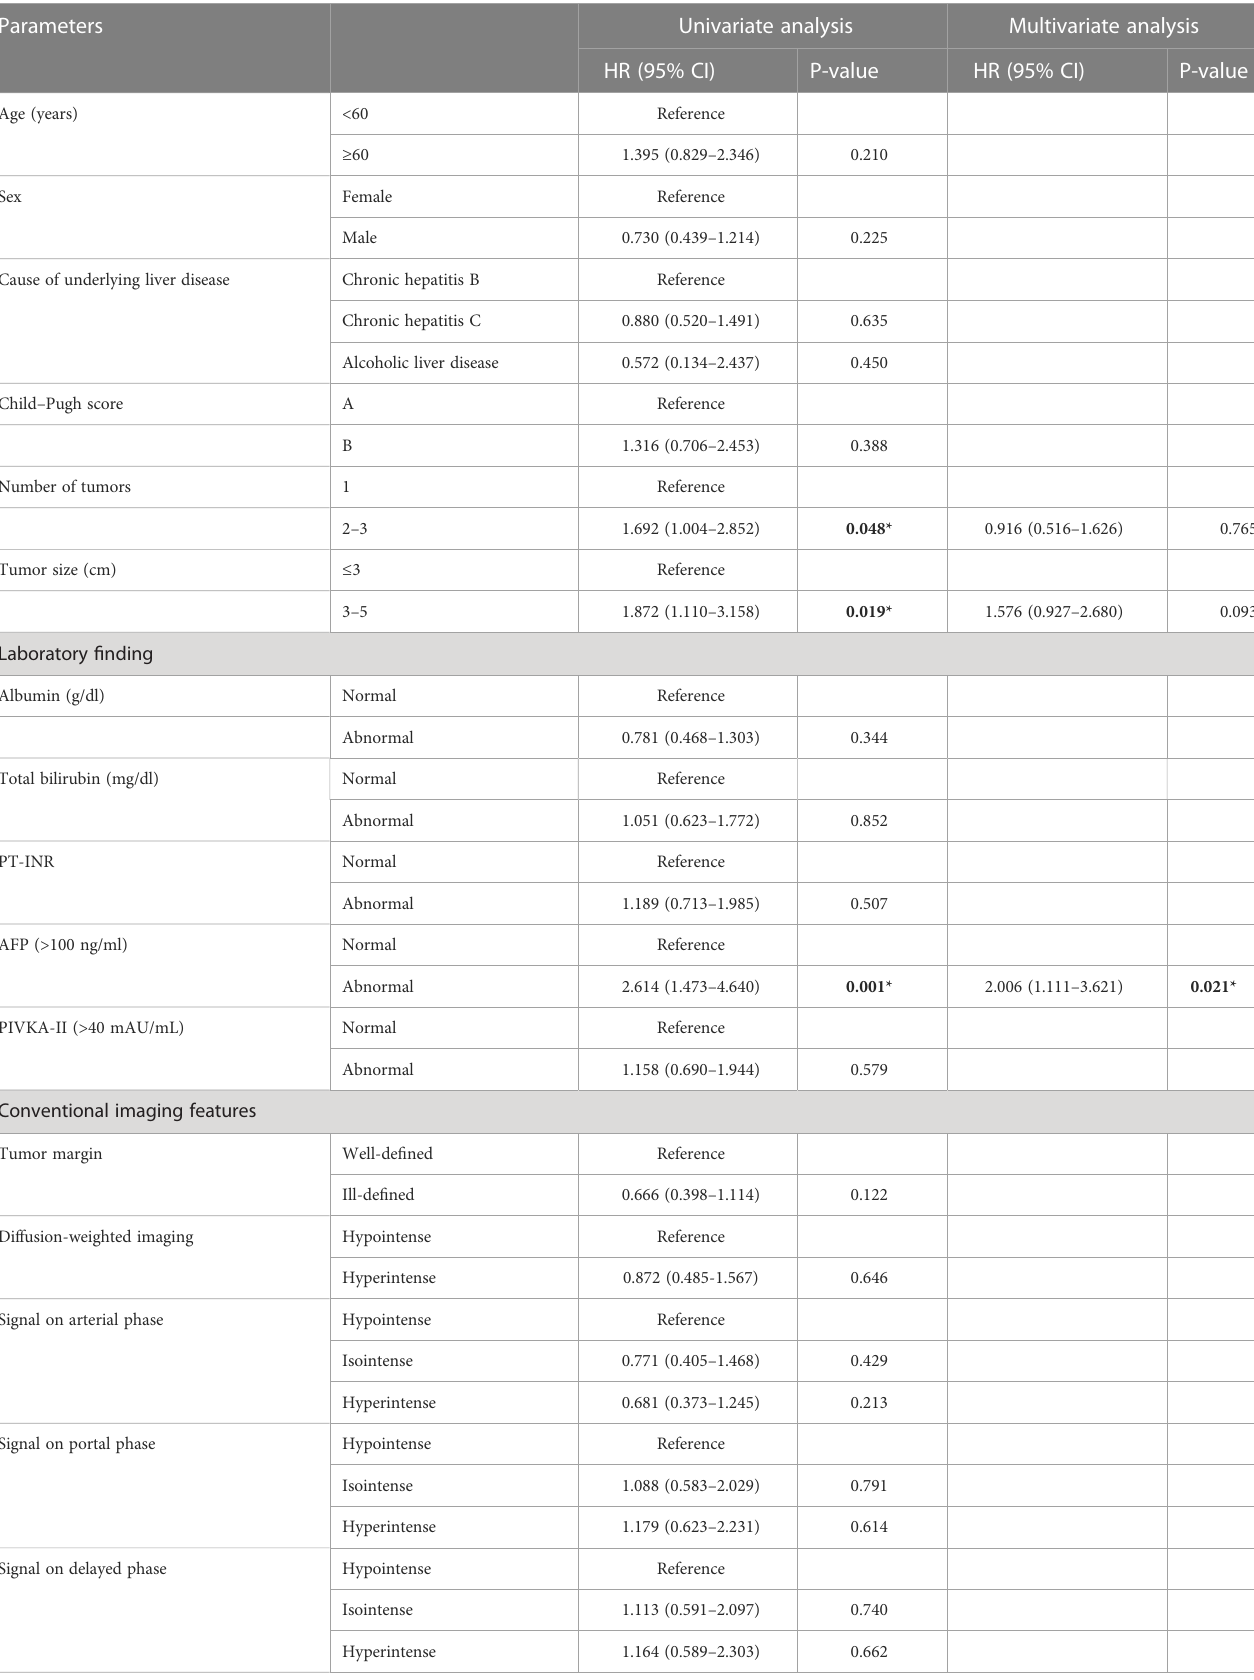
TABLE 2 Uni- and multivariate Cox analyses for risk factors for RFS in sHCC after